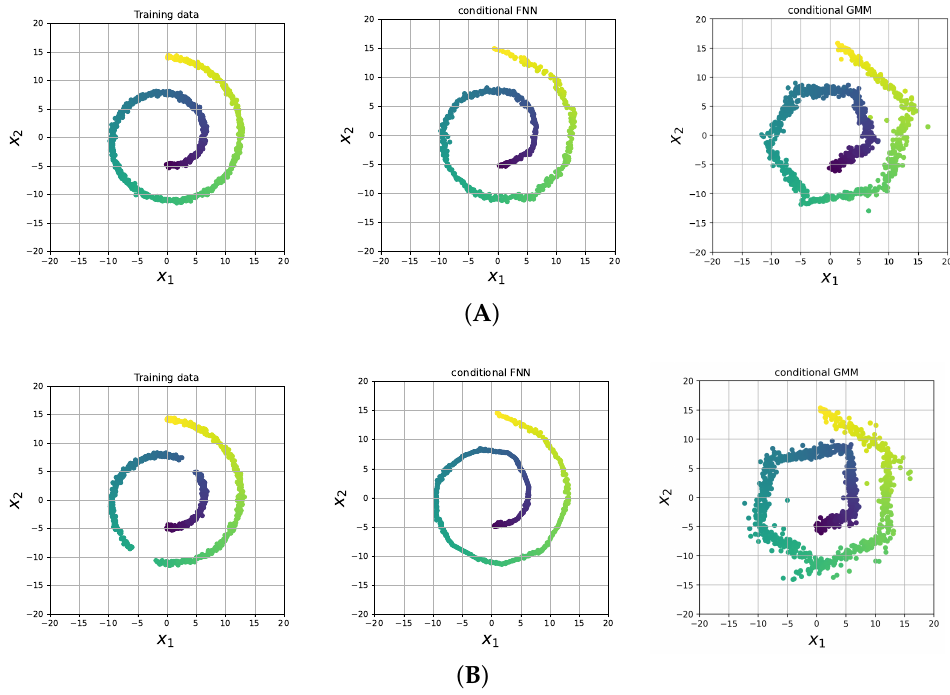
Figure 3. Real and generated samples of a 2-dimensional dataset of size N = 10,000 following a spiral-shaped distribution. Color indicates the value of the condition variable, y ∈ [ 0,1 ] . ( A ) Training data (left) where y belongs to to the whole interval [ 0,1 ] along with generated data using conditional FNN (middle) and conditional GMM (right) with K = 30 modes. ( B ) Training data (left) where y belongs to [ 0,0.25 ] ∪ [ 0.3,0.6 ] ∪ [ 0.65,1 ] . Generated data using conditional FNN (middle) and conditional GMM